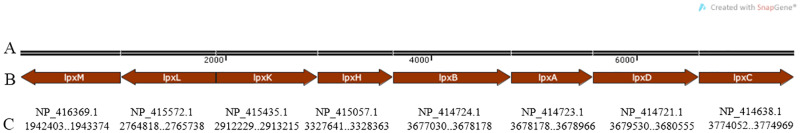
Analysis of the lpx coding cluster genes using data from E. coli K-12 substr.MG1655 (NCBI Reference Sequence: NZ_CP032667.1). A: The molecular size of the lpx coding cluster genes, B: The lpx coding cluster genes, their arrangement and directions, C: The lpx coding cluster genes NCBI code and their exact positions in the genome.